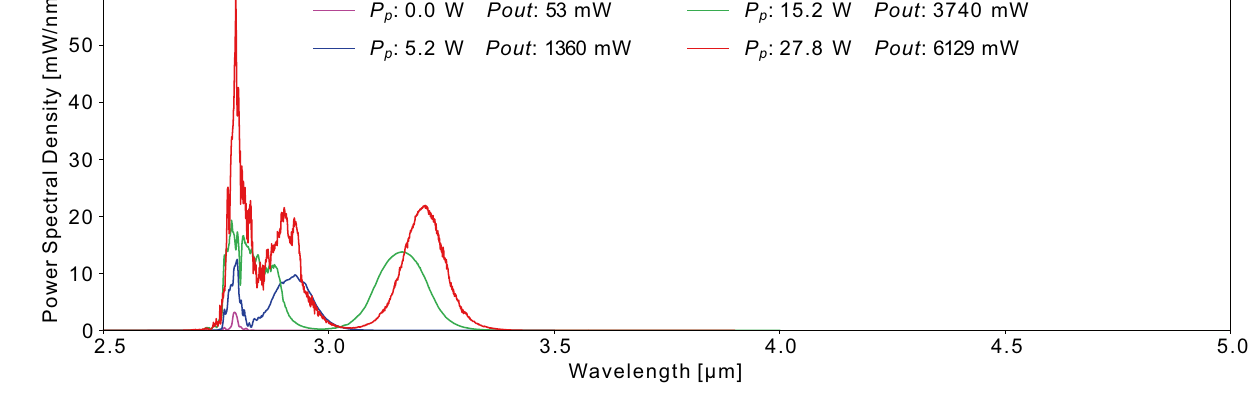
Figure 2. Power spectra at the output of the 4m active fiber for various values of Pp, the pump power. Pout is the output power. Seed pulse corresponds to the pink curve.